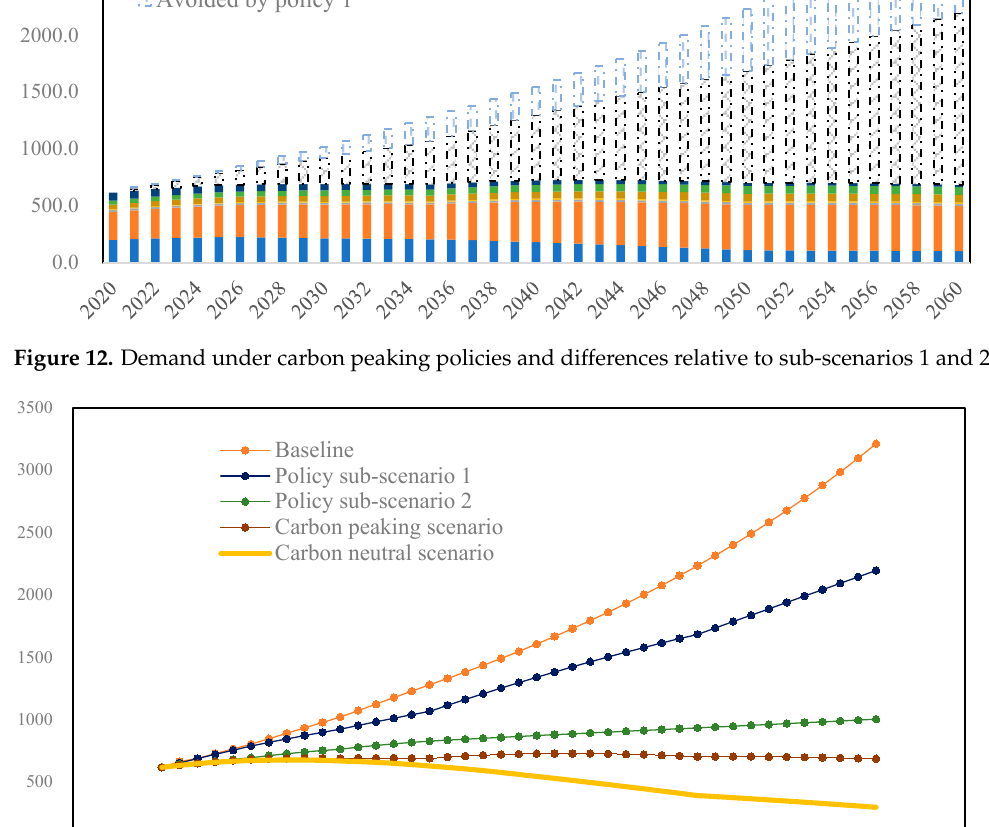
Figure 12. Demand under carbon peaking policies and di ff erences relative to sub-scenarios 1 and 2.